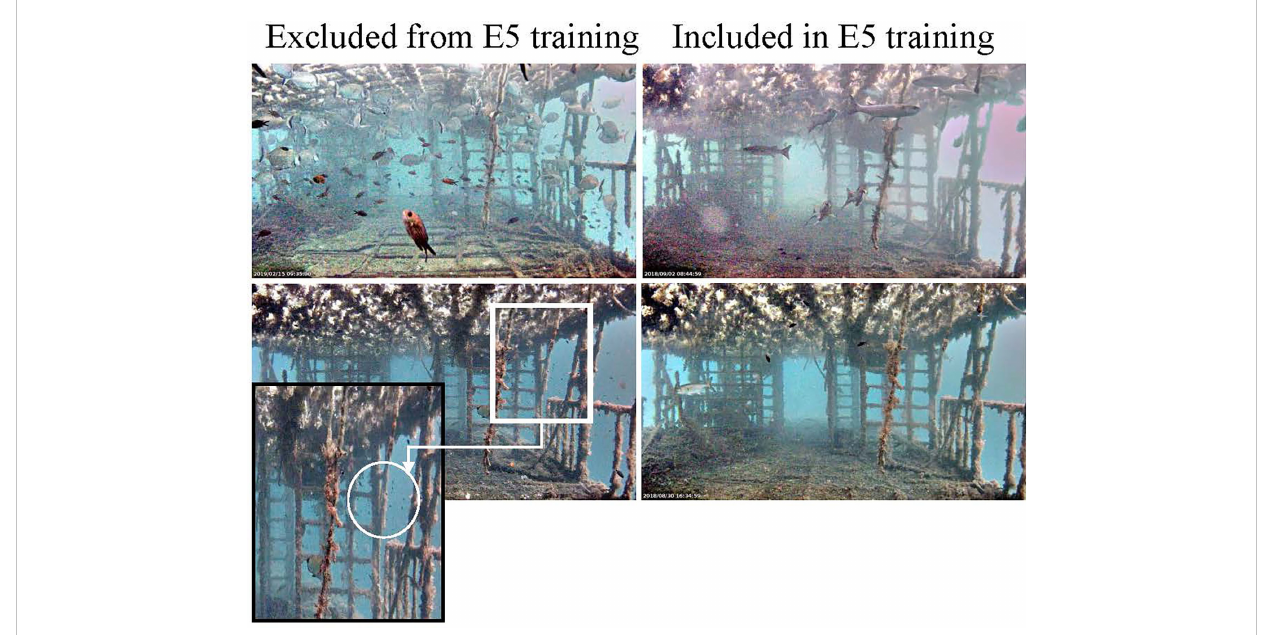
FIGURE 2 Left panel, images excluded from scenario E5 due to small fi sh and abundant overlap (note inset in the lower-left picture for small fi sh). Right panel: types of images included in scenario E5, selected for clearly identi fi able